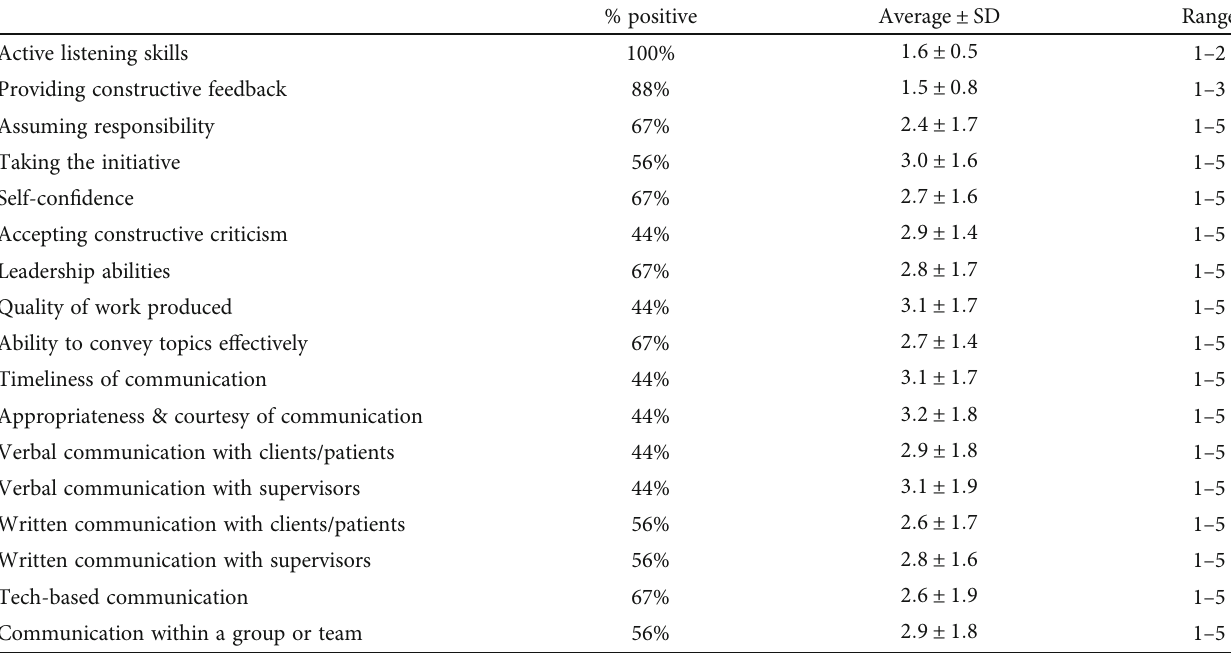
Table 3: Graduate student professional competency improvement.